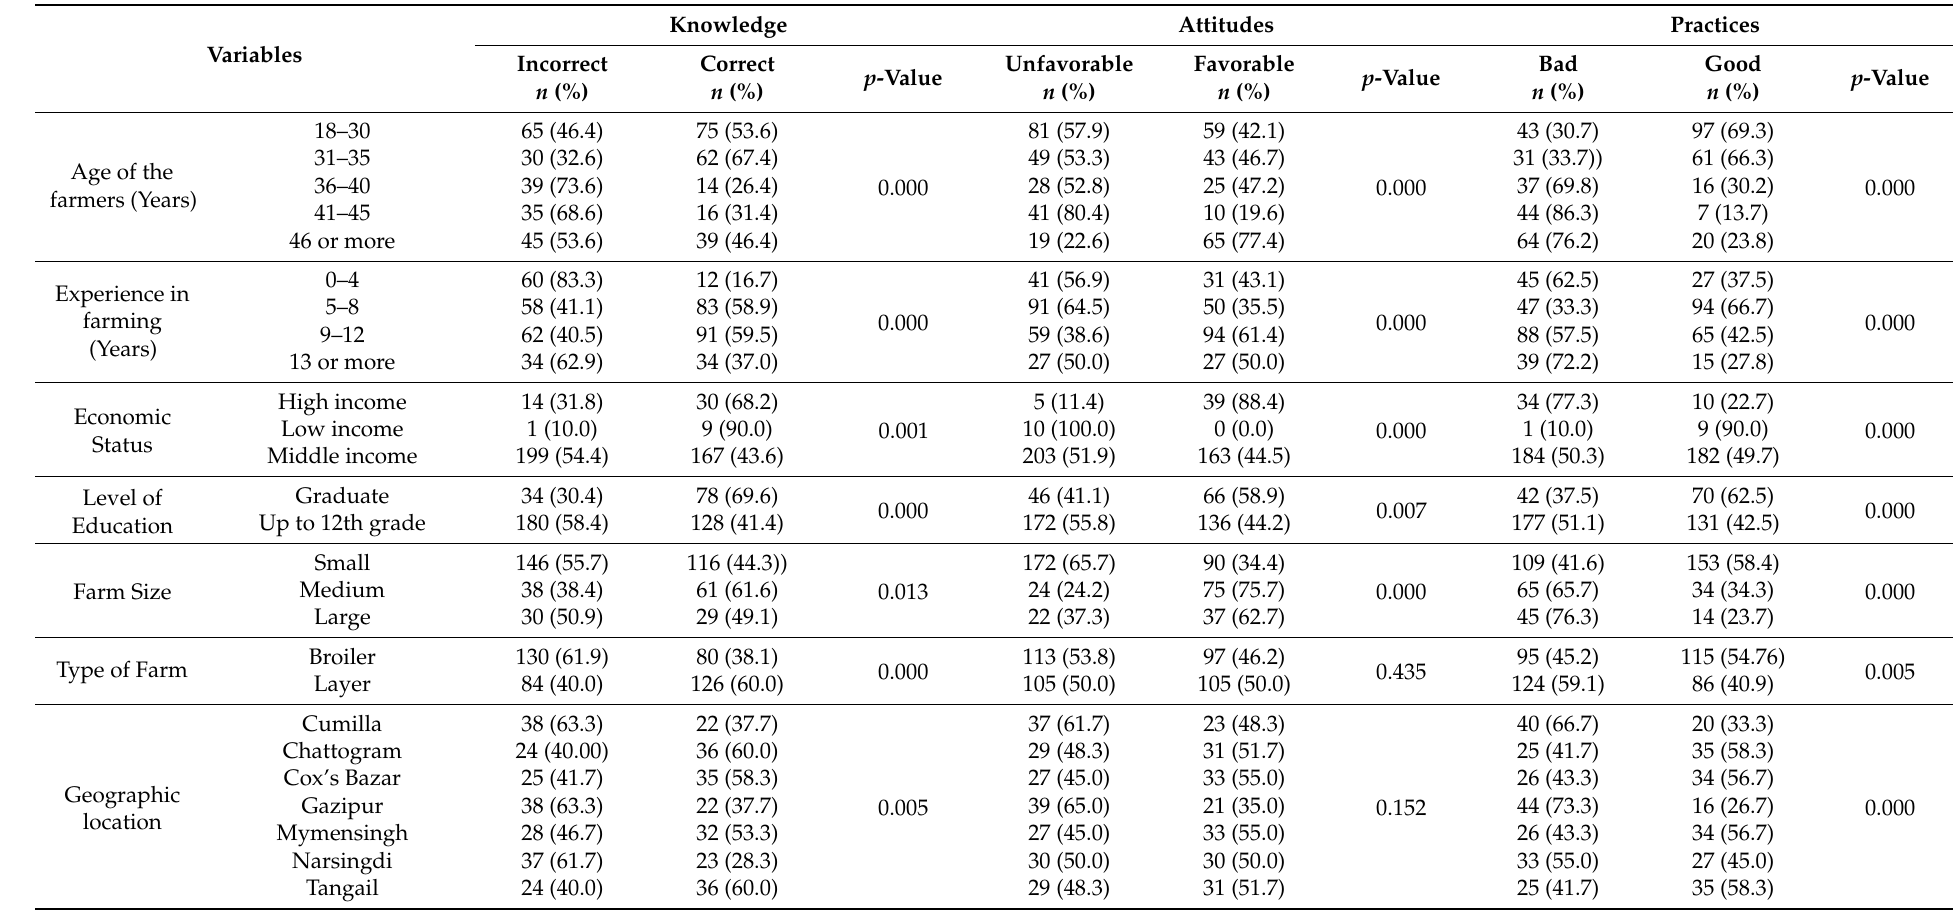
Table 5. Test of the statistical significances of the variations in the respondents’ knowledge of AMU and AMR by their